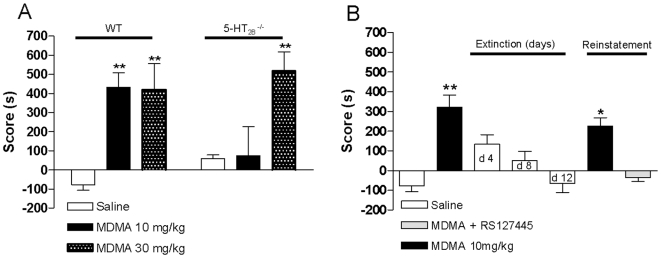
Effect of 5-HT2B receptor inhibition on MDMA-induced conditioned place preference in mice.
A) Repeated i.p. injection of MDMA 10 mg/kg induced CPP in WT mice compared to saline injection, but this effect was absent in 5-HT2B
−/− mice. However, repeated injection of a high dose of MDMA (30 mg/kg) induced CPP in WT as well as in 5-HT2B
−/− mice. Data (means±SEM, n = 8 per group) were analyzed by two-way ANOVA with genotype and treatment as main factors, revealing a significant interaction, F(2, 41) = 3.93, p<0.05, a main effect of treatment F(2, 41) = 11.67, p<0,001 but no effect of genotype F(1, 41) = 0.27, ns. Bonferroni tests were used for post-hoc comparisons. In all cases, p<0.05 was considered statistically significant; **p<0.01 compared to saline-treated mice. B) After an initial extinction of the CPP (12 days) in WT mice, MDMA (10 mg/kg) re-exposure induced reinstatement of CPP. MDMA-induced reinstatement was not observed in RS127445-pretreated mice. Data (means±SEM, n = 10−20 per group) were analyzed by one-way ANOVA. Dunnetts tests were used for post-hoc comparisons. The null hypothesis was rejected at the p<0.05 level; *p<0.05 **p<0.01 compared to saline-treated mice.